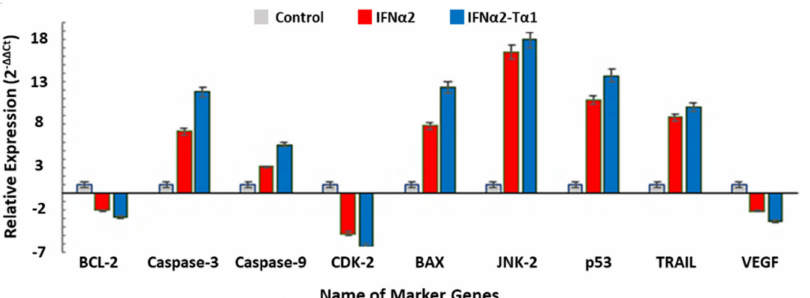
Figure 6. Relative expression of BCL2, CASP3, CASP9, CDK2 BAX, JNK-2, P53, TRAIL, VEGF genes measured by quantitative real-time PCR in IFN α 2–T α 1-treated cells compared with IFN α 2-treated cells. These data are presented as means of triplicate PCR experiments. Data are represented as Mean ± SD (n = 3, two-way ANOVA, p < 0.05 considered significant with 95% confidence).